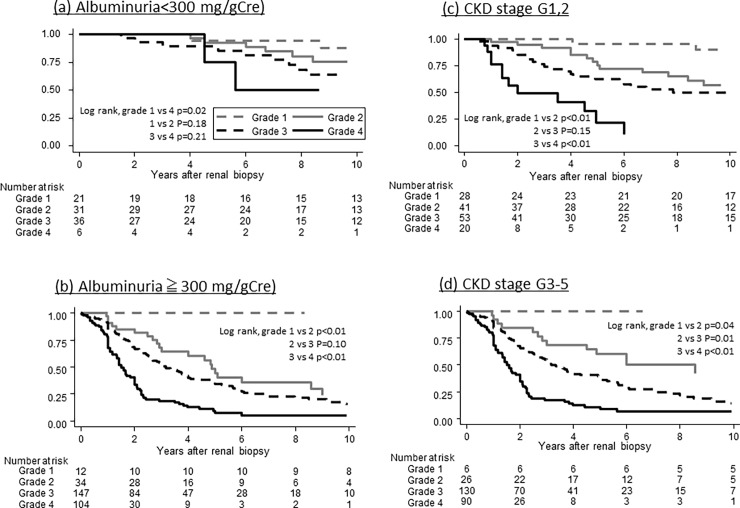
Renal survival after renal biopsy divided by pathological score categories and by level of urinary albumin and renal function.Abbreviations: Grade 1, J-score 0–5; grade 2, J-score; grade 3, J-score 11–15; and grade 4, J-score 16–19; CKD, chronic kidney disease.